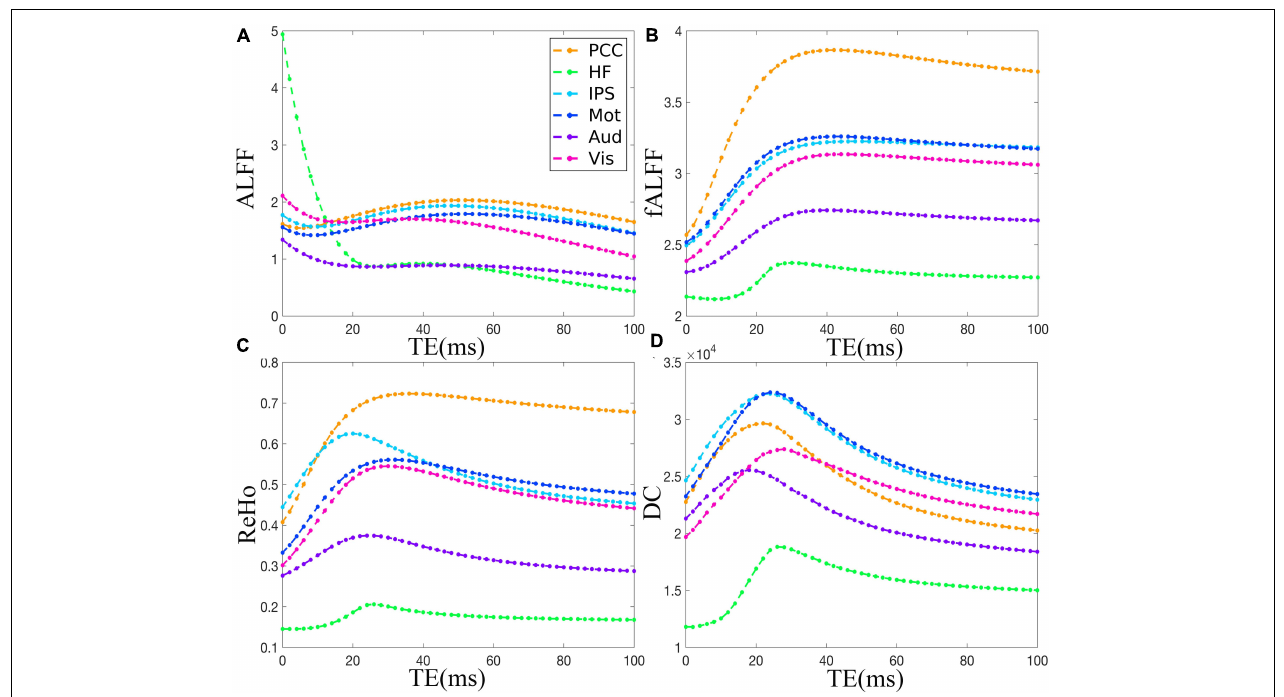
FIGURE 4 | The simulation of the TE dependency of the group-averaged ALFF (A) , fALFF (B) , ReHo (C) , and DC (D) of six ROIs, i.e., PCC, HF, IPS, Mot, Aud, and Vis, across all subjects under eyes closed condition. TE, echo time; ALFF, amplitude of low-frequency fluctuation; fALFF, fractional ALFF; ReHo, regional homogeneity; DC, degree centrality; ROIs, regions of interest; PCC, posterior cingulate cortex; HF, left hippocampal formation; IPS, left intraparietal sulcus; Mot, left primary motor cortex; Aud, left auditory cortex; Vis, left primary visual cortex.